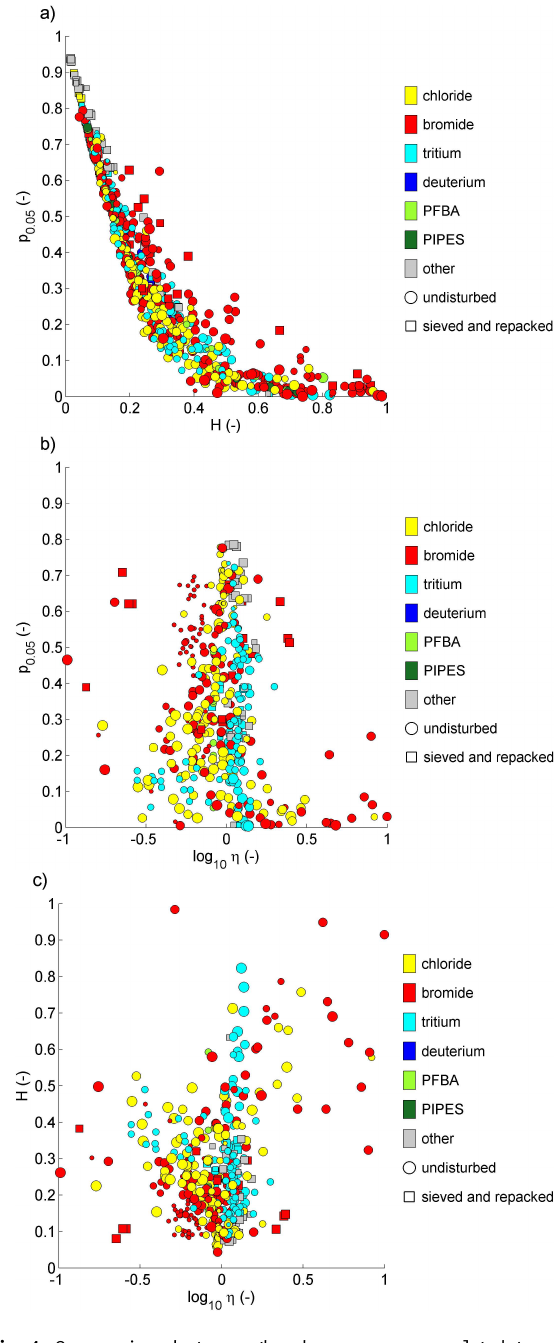
Fig. 4. Comparison between the shape-measures related to early tracer arrival: (a) comparison between the holdback, H , and the normalized 5%-arrival time, p 0 . 05 ; (b) comparison of the piston- flow to transport velocity ratio, η , and the normalized 5%-arrival time, p 0 . 05 ; (c) comparison of the piston-flow to transport velocity ratio, η , and the holdback, H. In addition, the type of applied tracer is depicted. The symbol size corresponds to the water fluxes, q , un- der which the experiment was conducted, small symbols indicating small water fluxes, large symbols denoting large water